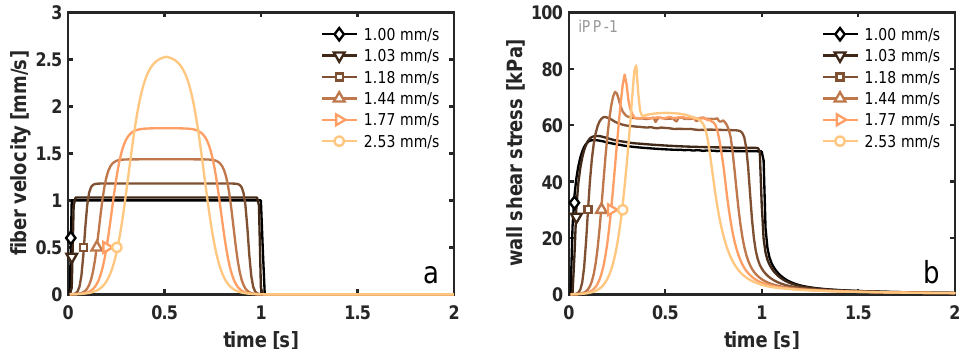
Figure 10. ( a ) The prescribed velocity profiles at the fiber surface and ( b ) the corresponding wall shear stress at the fiber surface as a function of time. These simulation results represent the iPP-1 matrix